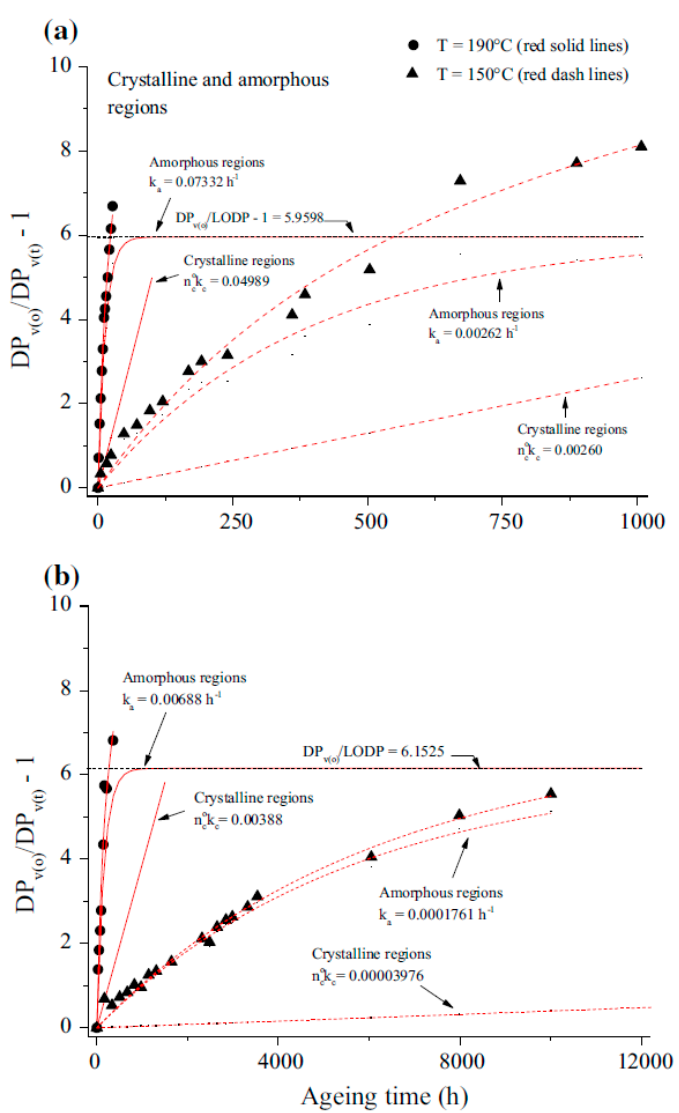
Figure 3. Two-branch patterns of amorphous and crystalline regions obtained during accelerated ageing at 150 and 190 °C: ( a ) standard Kraft paper (Clupak-HD75), ( b ) thermally upgraded paper (Densiflex-22HCC, 1.8% N) [29] .